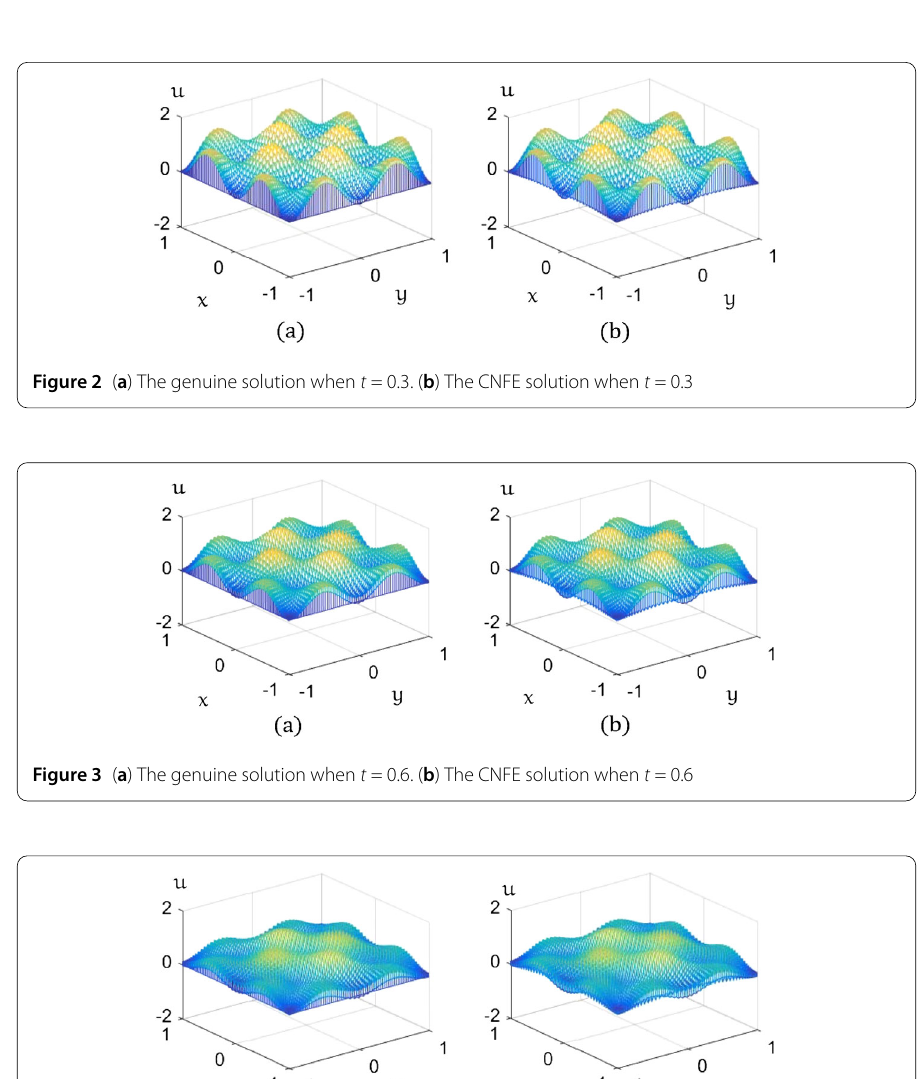
O (10 –4 ), signifies that the CNFE method is effective and reliable for calculating the 2D uni- form transmission line equation. In Table 1, we also give the errors between the genuine and FE solutions and CPU run times when t = 0.3, t = 0.6, and t = 0.9 using the